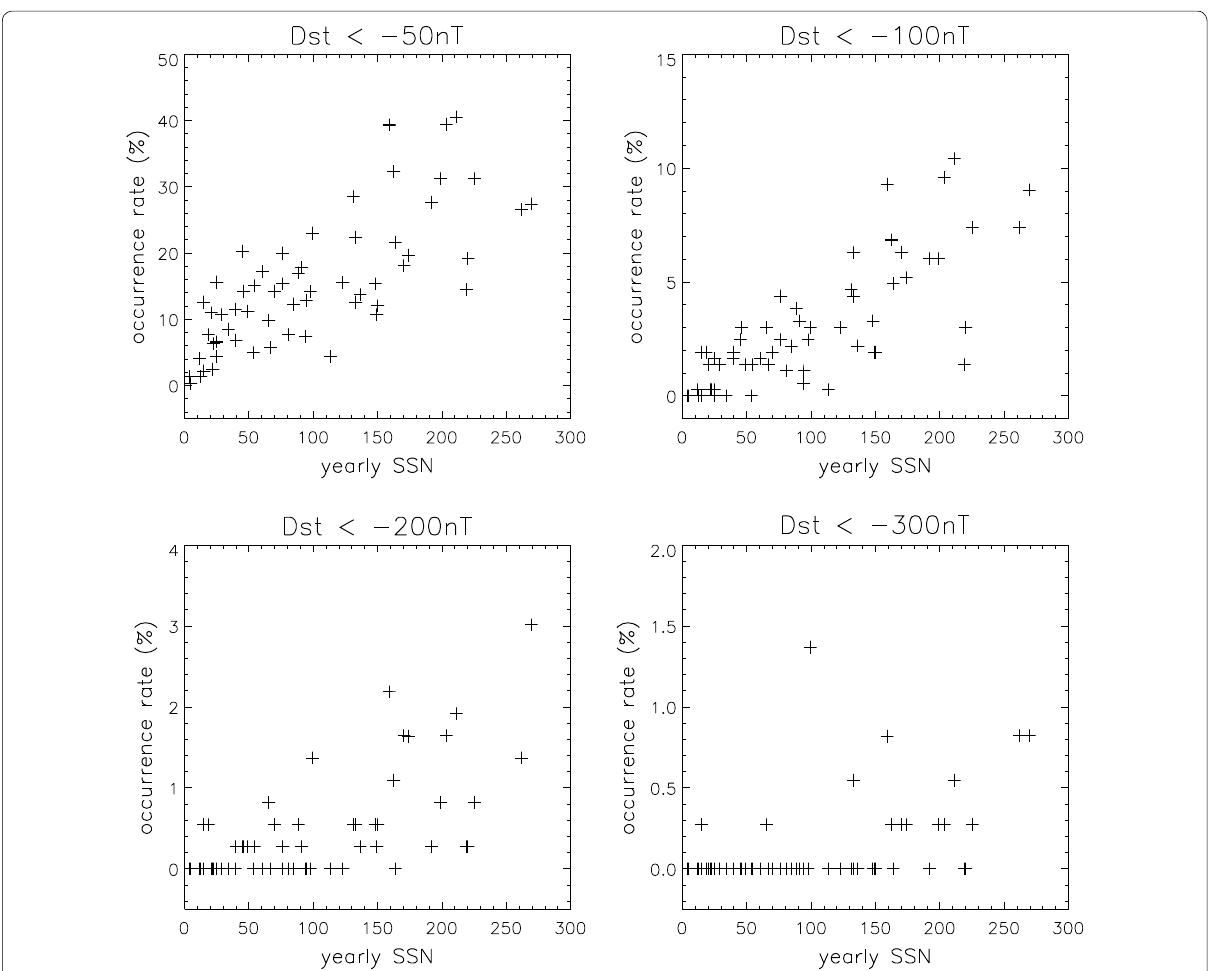
Fig. 2 Yearly SSNs and the yearly occurrence rates of the daily minimum Dst of less than